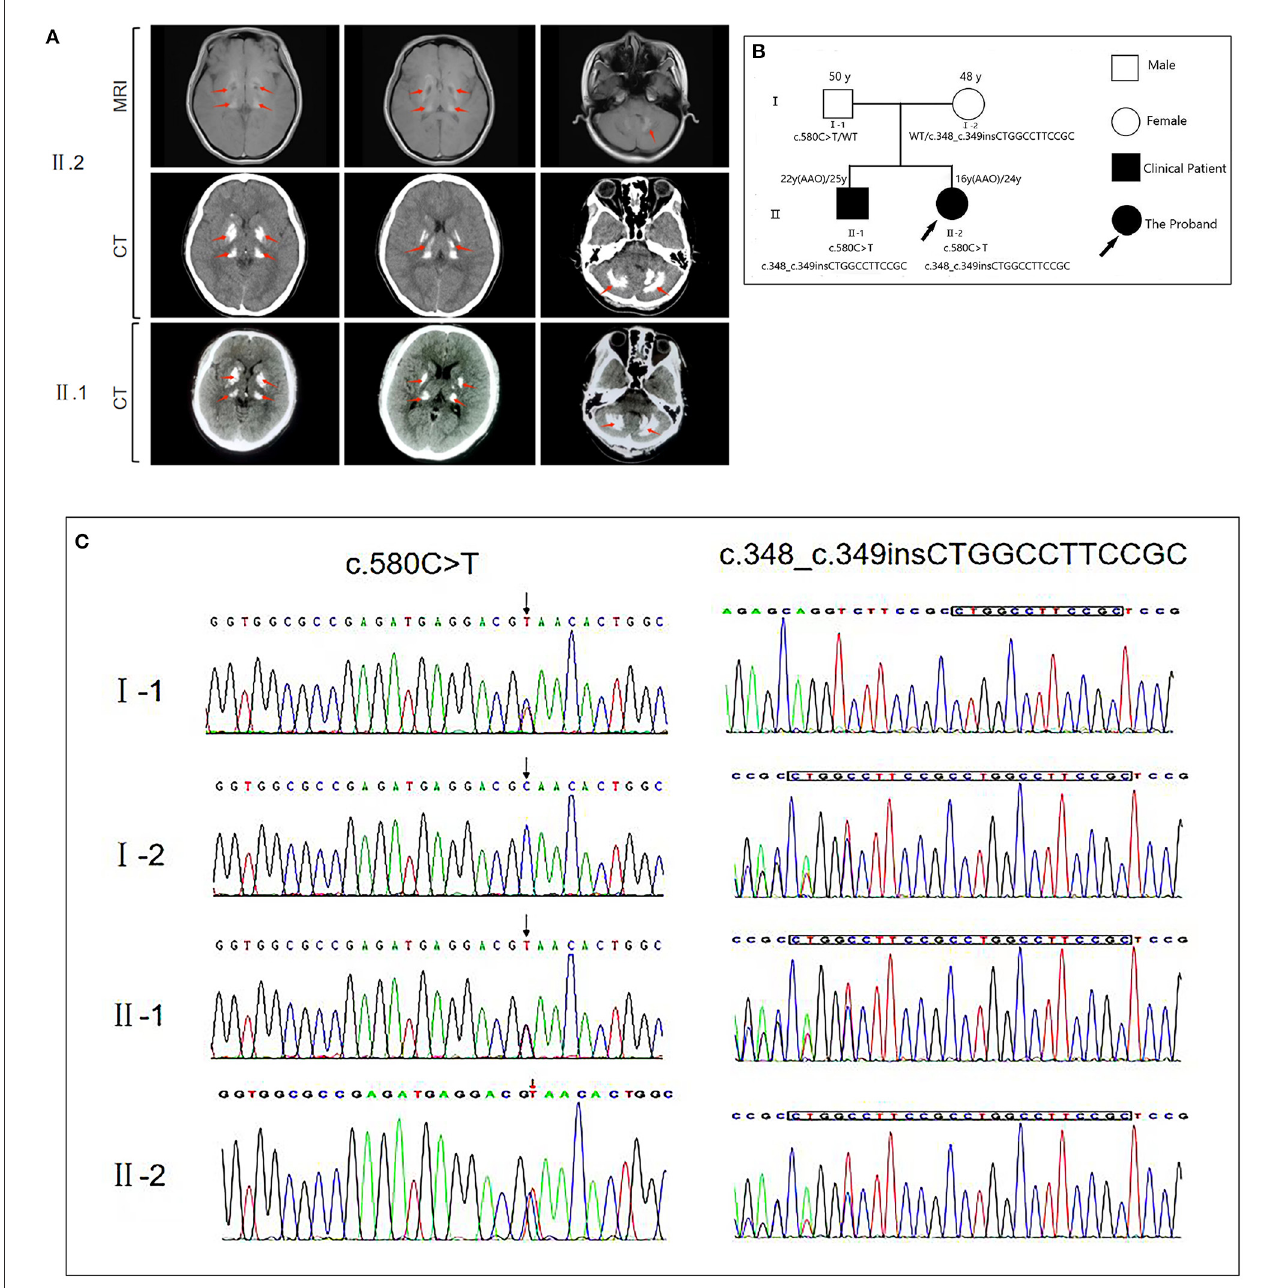
FIGURE1 (A) Brain magnetic resonance imaging (MRI) and computed tomography (CT) for the proband (II.2) reveal bilateral calcification in the basal ganglia, thalamus, cerebellum, and pons. CT of the proband’s brother (II.1) reveals bilateral calcification in the basal ganglia, thalamus, and cerebellum. The calcification sites showed a high degree of similarity between the patients. (B) The genetic pedigree for this case. (C) MYORG gene sequencing of the family members of this case. FM, family; AAO, age at onset; WT, wild